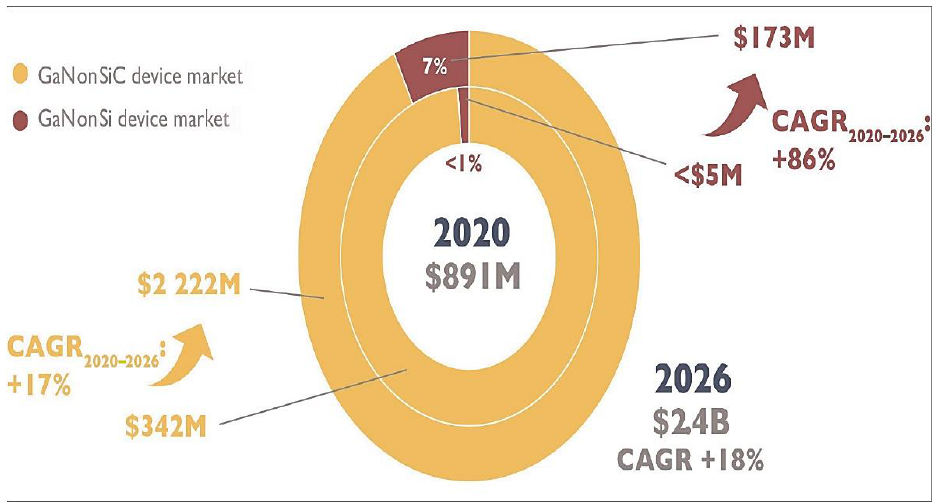
Figure 8. GaN RF application breakdown by substrate markets as compiled in 2021 by Yole. Repro- duced with permission [6]. Copyright 2021, published by Yole